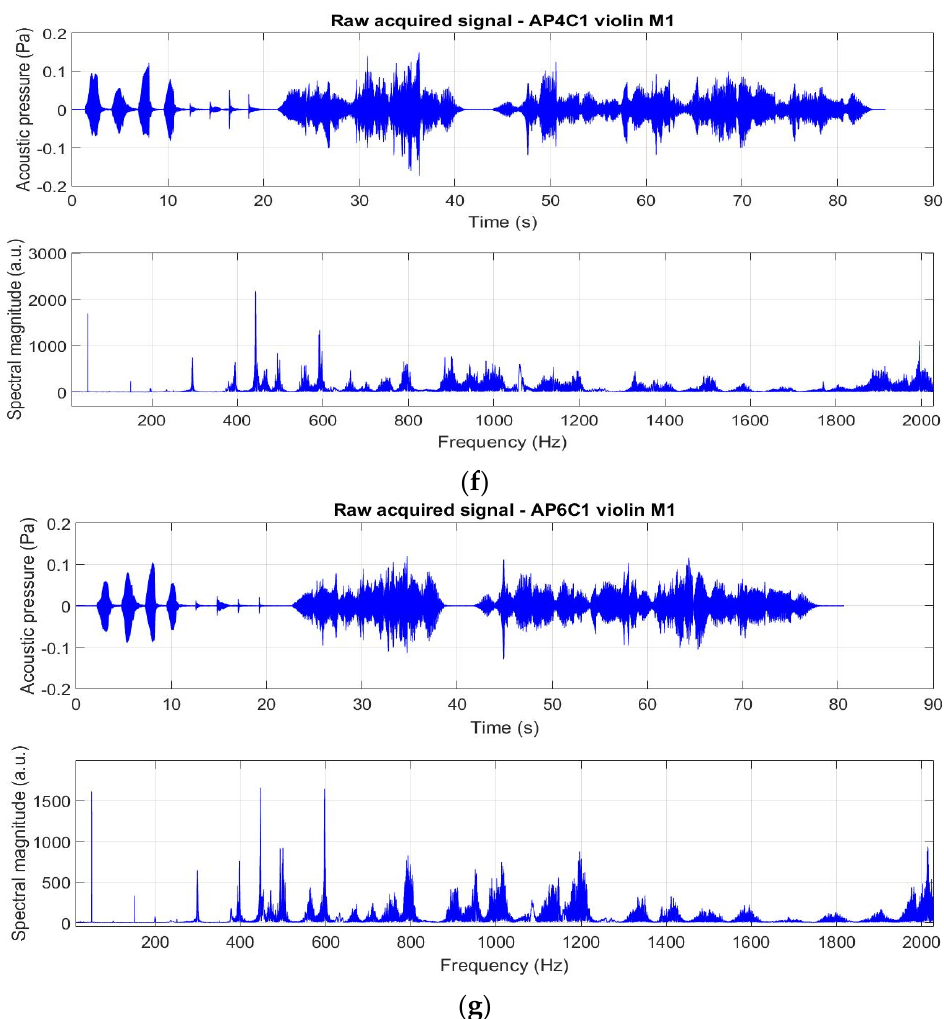
Figure 5. The acoustic signals played on the violins: ( a ) AM6C1; ( b ) AM4C1; ( c ) AM2C1; ( d ) A00C1; ( e ) AP2C1; ( f ) AP4C1; ( g ) AP6C1. (Legend: a.u. represents the notation for arbitrary units.).